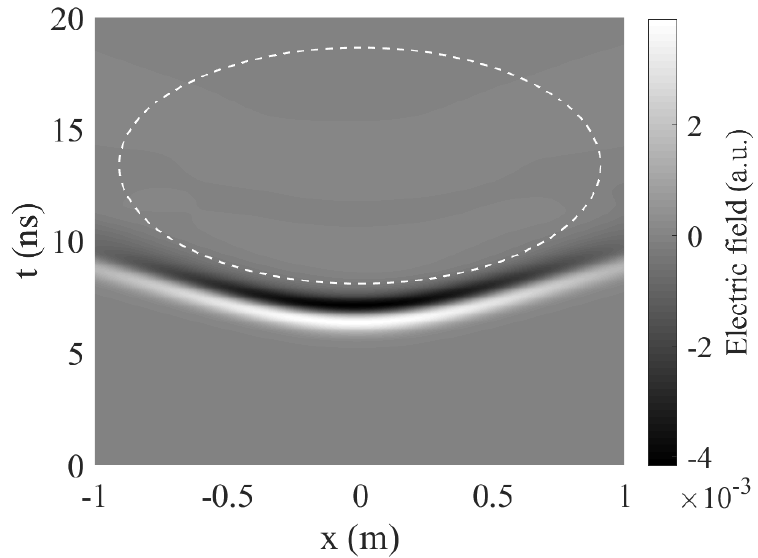
Figure 6. B-scan GPR image when the electromagnetic source is placed 15cm above the air-dispersive soil surface and the pipe is buried 50 cm under the same surface. Reproduced with permission